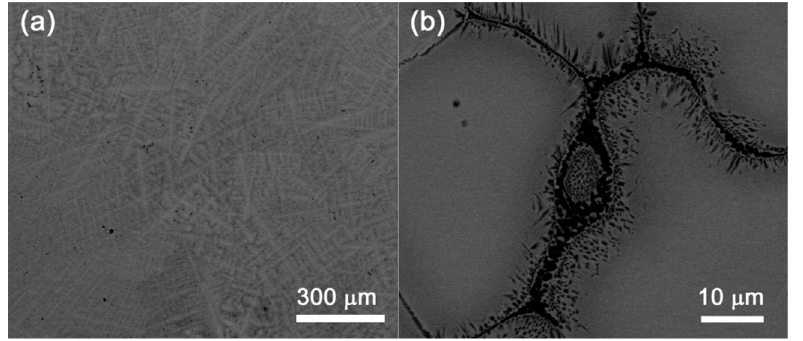
Figure 12. SEM micrograph (back-scattered electrons) of HfNbTiVZr alloy in the as-cast state: ( a ) an overview of the microstructure, ( b ) detail of grain boundary with V-rich particles.